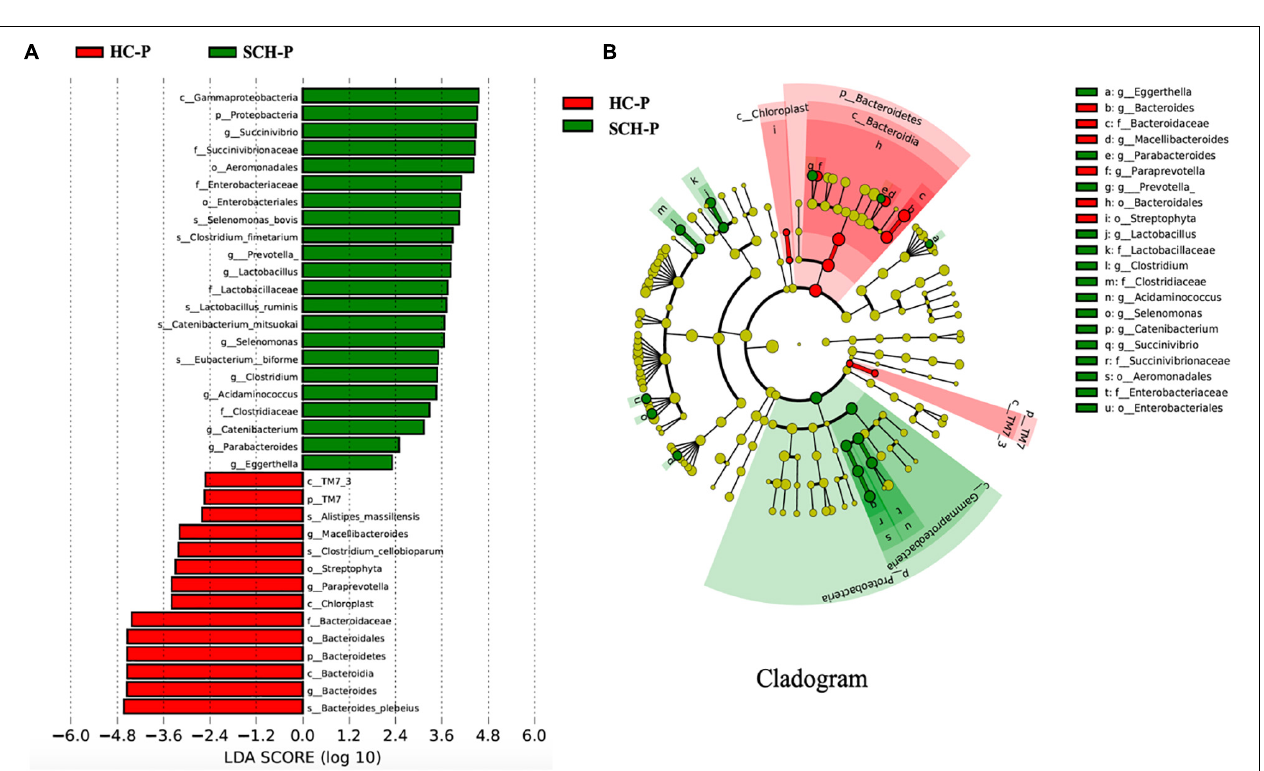
FIGURE 2 | Differently abundant taxa identified using LEfSe analysis. (A) Visualization of only taxa meeting an LDA threshold > 2. (B) LEfSe Cladogram showed the most differentially abundant taxa between the two groups. Taxa enriched for healthy with Prevotella-enterotype in red; schizophrenia with Prevotella-enterotype-enriched taxa in green. The brightness of each dot was proportional to its effect size.